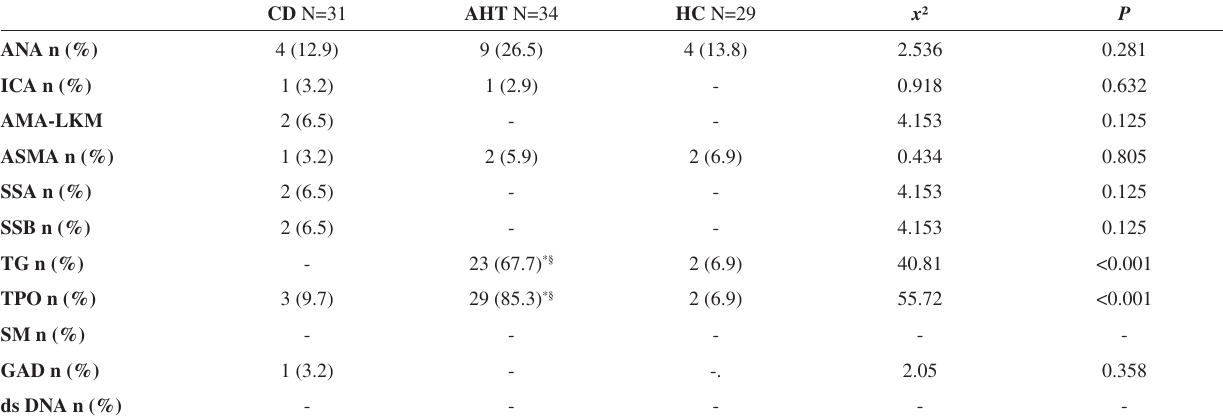
Table 3 - Ratio of antibody positivity in